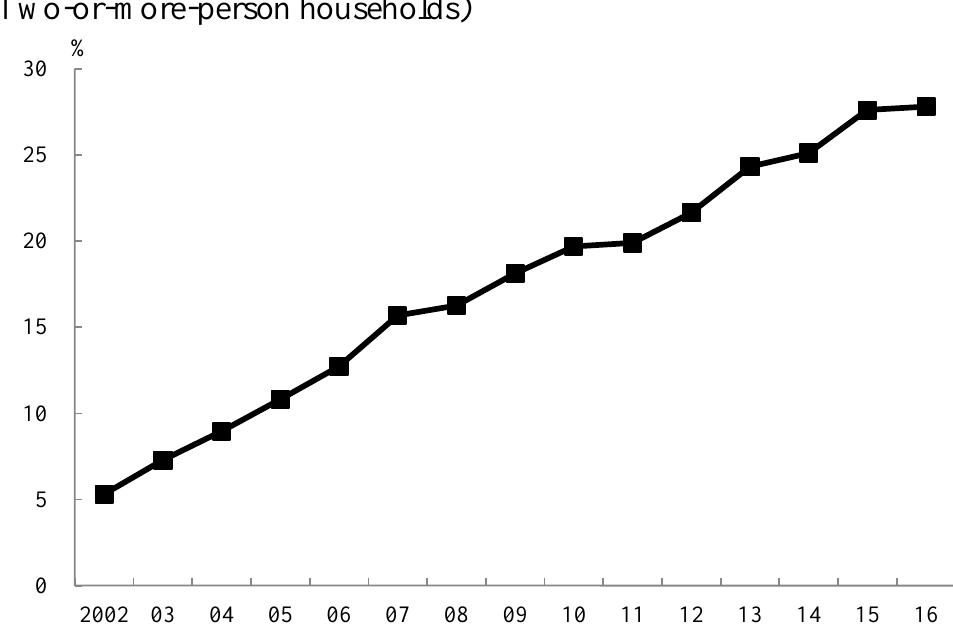
Source: Statistics Bureau,